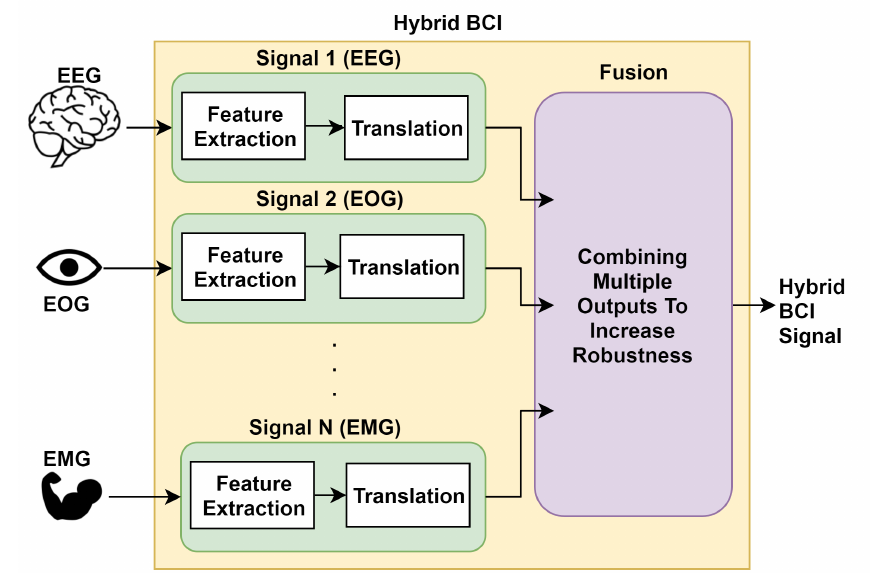
Figure 1. Block diagram of Hybrid Brain-Computer Interface